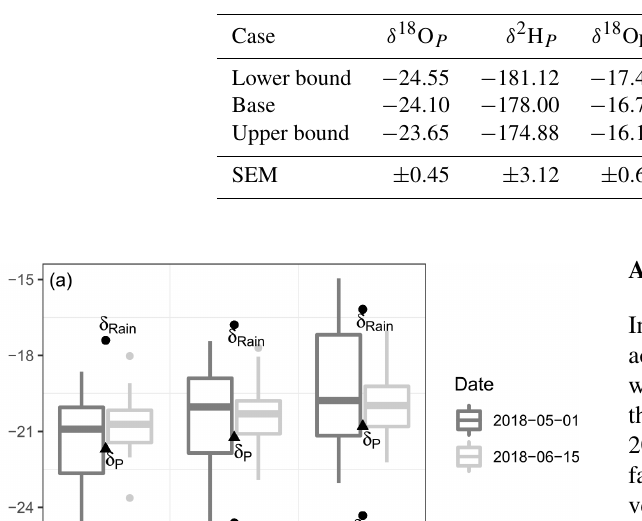
Table B2. Comparison of isotope framework parameters for upper- and lower-bound cases.